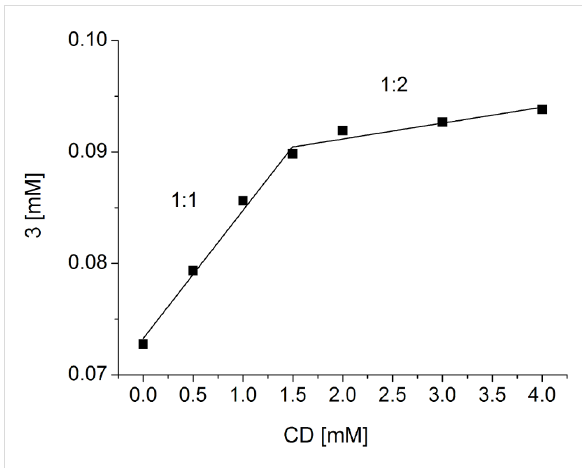
Figure 5: Higuchi–Connors phase diagram of 3 /m- β -CD complex.